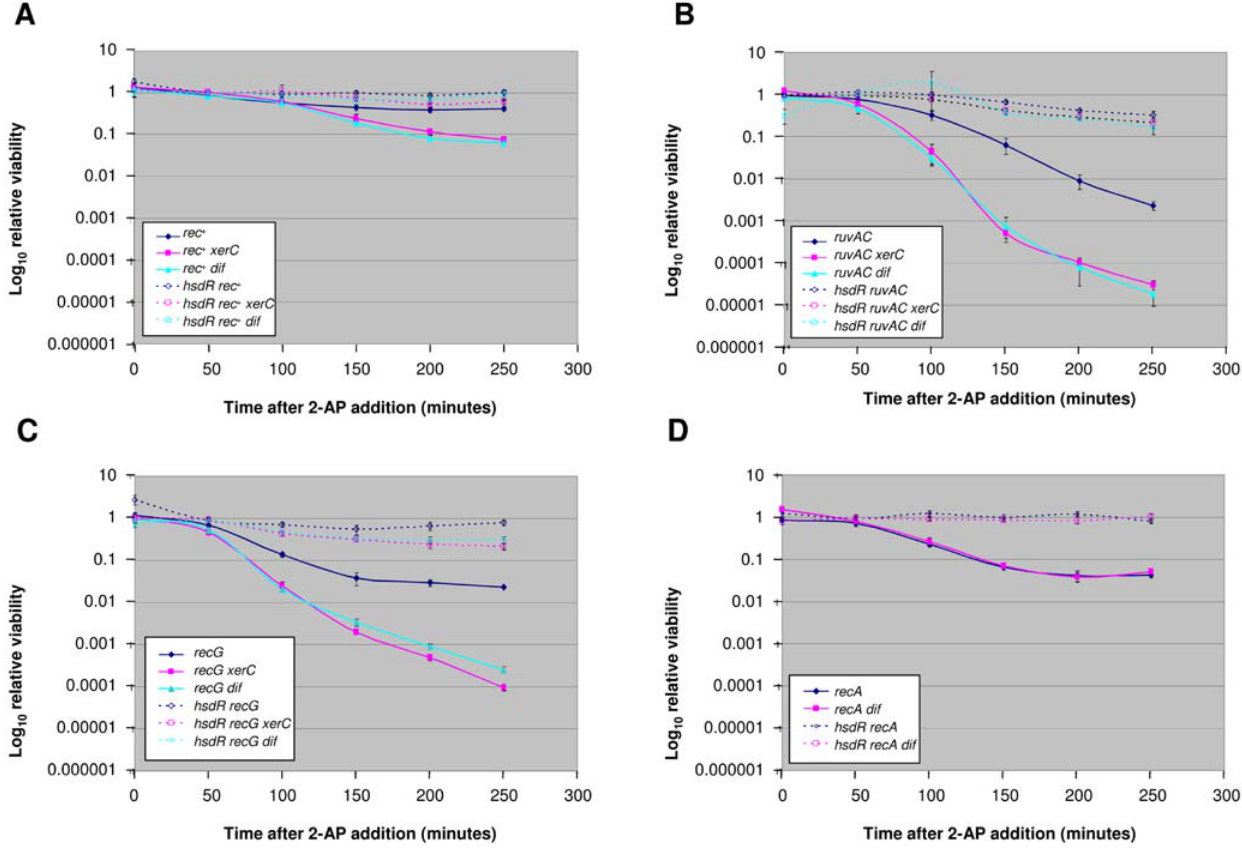
Figure 4. Effect of xerC and dif mutations on cell sensitivity to EcoKI breaks. Exponential cultures were treated with 20 m g/ml of 2-AP and relative viability calculated as described in Experimental Procedures. Error bars indicate 95% confidence intervals. In addition to the genotypes shown, all strains carry the D clpX deletion. (A) Strains used were DL1902 ( rec + ), DL1930 ( rec + xerC ), DL2245 ( rec + dif ), DL1800 ( hsdR rec + ), DL2097 ( hsdR rec + xerC ) and DL2244 ( hsdR rec + dif ). (B) Strains used were DL1938 ( D ruvABC ), DL1952 ( D ruvABC xerC ), DL 2249 ( D ruvABC dif ), DL2114 ( hsdR D ruvABC ), DL2118 ( hsdR D ruvABC xerC ) and DL2248 ( hsdR D ruvABC dif ). (C) Strains used were DL1940 ( D recG), DL1944 ( D recG xerC ), DL2346 ( D recG dif ), DL2133 ( hsdR D recG ), DL2136 ( hsdR D recG xerC ) and DL2345 ( hsdR D recG dif ). (D) Strains used were DL2656 ( recA ), DL2903 ( recA dif ), DL2666 ( hsdR recA ) and DL2904 ( hsdR recA dif ).